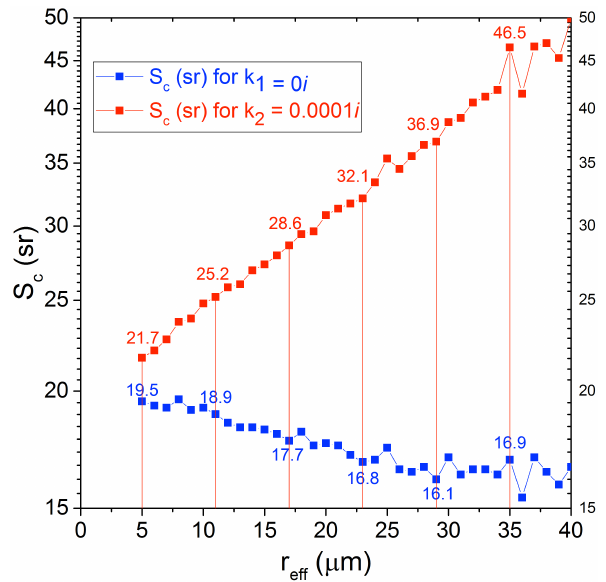
Figure 9. Sensitivity study of lidar ratio ( S c , sr) as a function of the cloud droplets effective radius, using a two-parameter gamma size distribution in Mie code. The effective variance, v eff , is set to 0.088. The real part of the refractive index is fixed to 1.337, while the imaginary part, k , was set to 0 (blue) and to 0.0001 i (red).